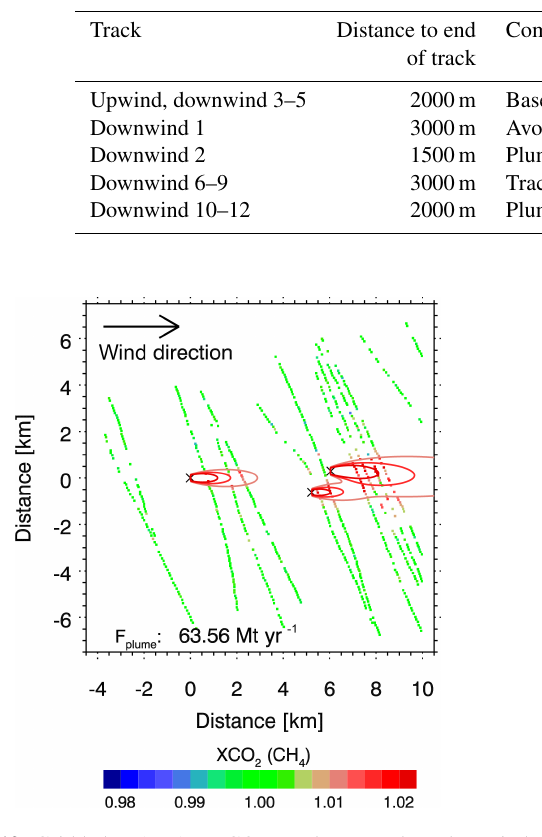
Figure 12. Gridded MAMAP XCO 2 results rotated so that wind direction points into positive x direction and contour lines of the inferred plume models for the individual power plants. Total emis- sion rate is 63.6MtCO 2 yr − 1 for the time of the overflight. Ground scenes are shown slightly enlarged for better